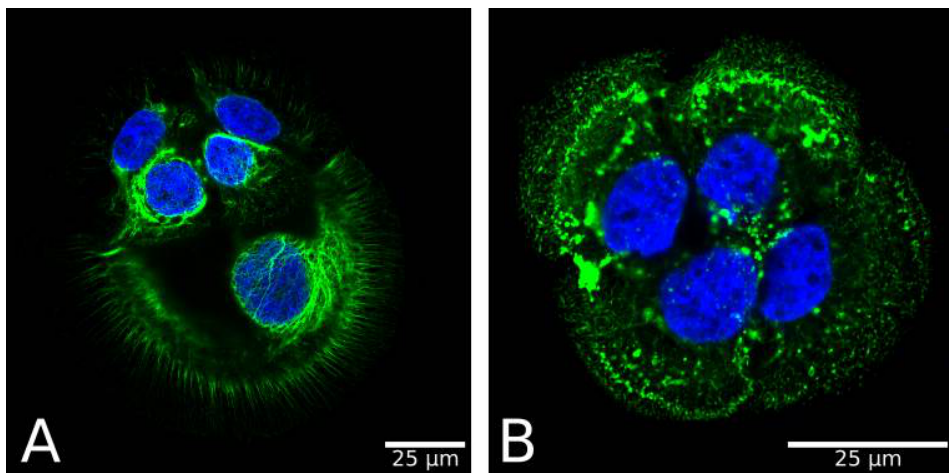
Figure 5. Wild-type and mutant HACAT D7 clone with disrupted KIF. ( A ). HACAT wild type. ( B ). Mutant HACAT D7. CRISPR/Cas9 technology was applied to modify KRT5 in HaCaT cells. Paired gRNAs specific to exon 7 of the KRT5 gene were used. WT—HACAT with wildtype K5; D7—mutation K5 L473P. Aggregates were observed in nondividing cells. Confocal images of immunofluorescence analysis of cells with antibodies against KRT5 (ab207351). Images are adopted from [110].